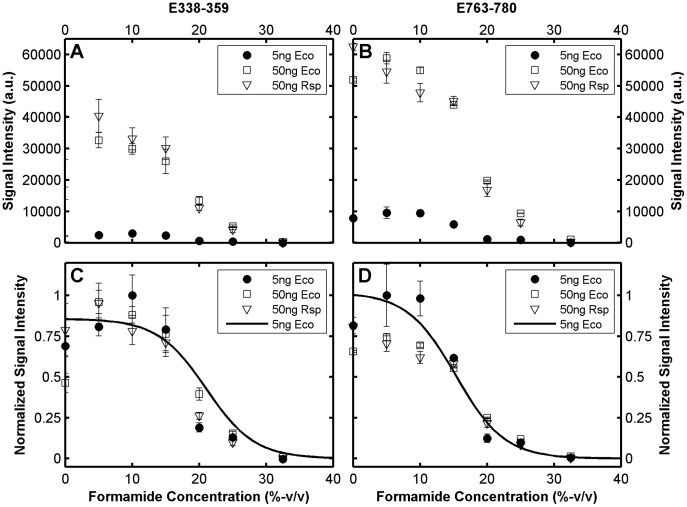
Effect of target concentration and type of target molecule on formamide denaturation profiles.Probes E338–359 (A and C) and E763–780 (B and D) are shown. Both probes perfectly match the 16S rRNA gene of both E. coli (Eco) and R. sphaeroides (Rsp).